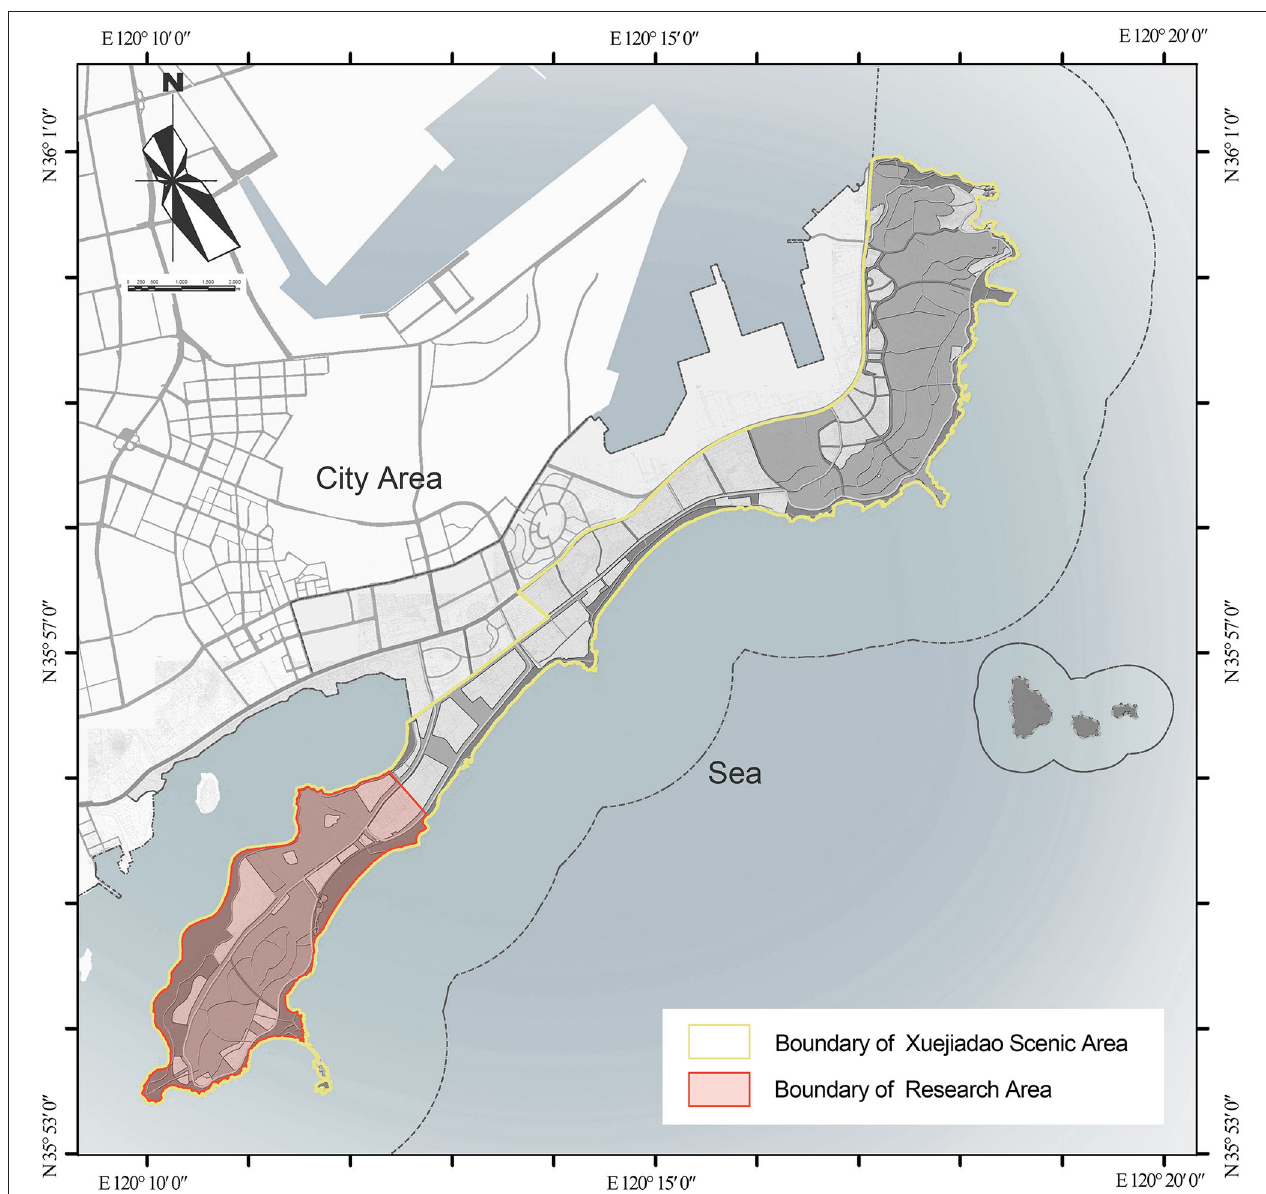
FIGURE 2 | Geographic coordinate information and boundaries of the research